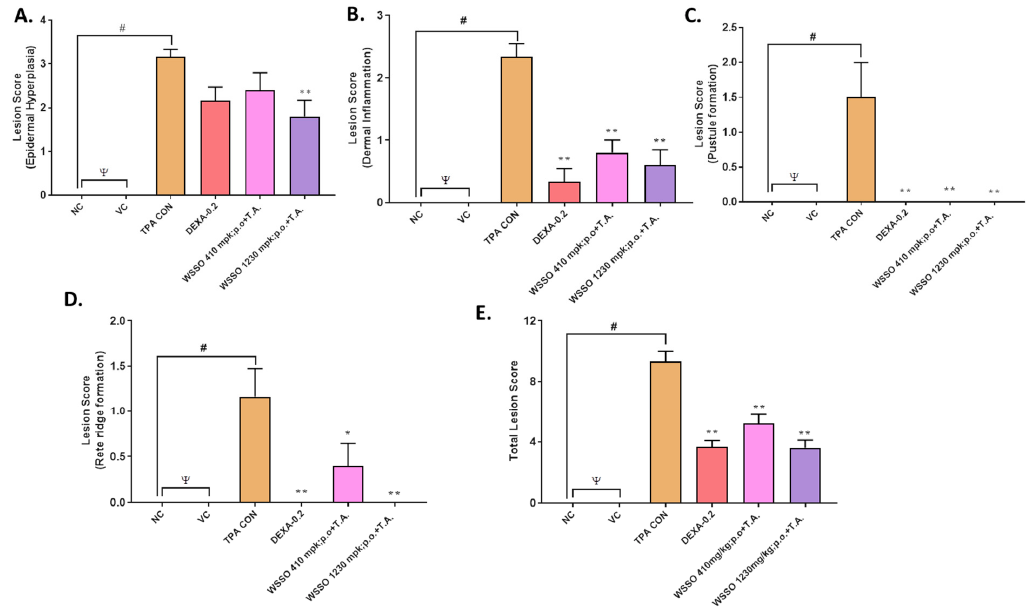
Figure 7. WSSO reduces the TPA-induced psoriatic histopathological score: TPA-induced inflammatory lesions were reduced by treatment with WSSO or DEXA. ( A ) Lesion score of epidermal hyperplasia reduced significantly by 1230 mg/kg WSSO treatment ( p < 0.005). ( B ) Dermal inflammation reduced significantly post-treatment with WSSO ( p < 0.001) at different doses in comparison to TPA CON. ( C ) Pustule formation score at epidermis reduced drastically with high significance after WSSO ( p < 0.001) and DEX ( p < 0.001) treatment compared to TPA CON; ( D ) Rete ridge formation was also inhibited, more significantly at 1230 mg/kg ( p < 0.001) compared to 410 mg/kg ( p < 0.05) of WSSO. Both of the WSSO treatments were supplemented with topical application (T.A.) of 20 µL of WSSO. ( E ) Total lesion score was calculated and significant reduction was observed after treatment with WSSO 410 and 1230 mg/kg ( p < 0.001) and DEXA ( p < 0.001) compared to TPA control. Values are presented as mean ± SEM, n = 6 samples in each group, ψ = non-significant (NC vs. VC), # p < 0.001 (NC vs. TPA), * p < 0.01, ** p < 0.001 (treated vs. TPA